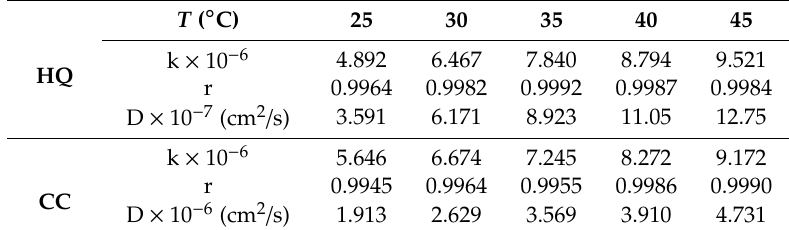
Figure 7. The relationship between I pa and v 1/2 of ( a ) HQ and ( b ) CC at different temperatures. Table 2. Diffusion coefficients of HQ and CC at different temperatures.